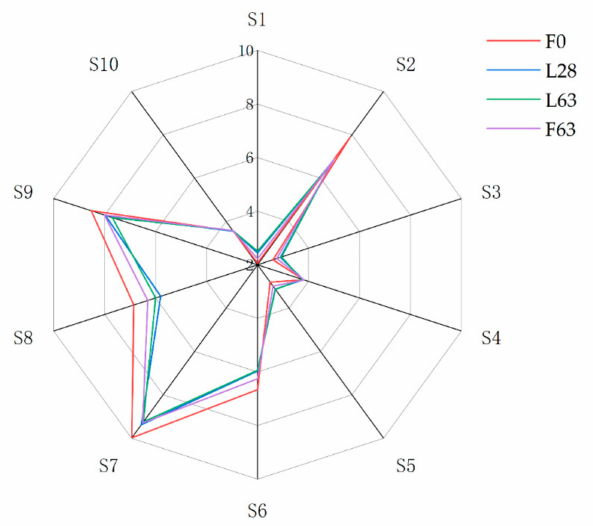
Figure 4. Radar plot of the volatile compounds of noni juice at different fermentation times and scales by E-nose. The data are normalized as a result of LOG 2 (mean value ×